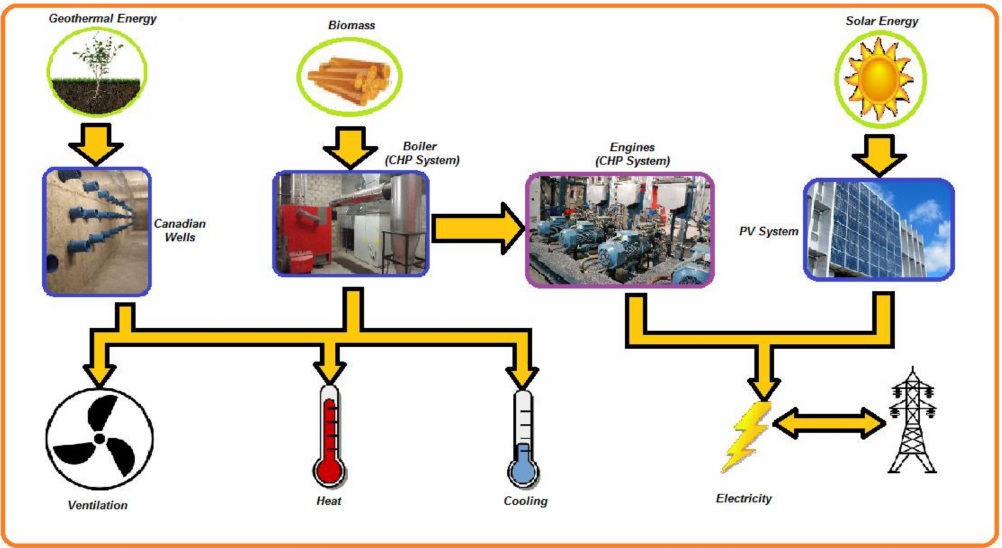
Figure 3. Renewable energy generation systems used in the building.